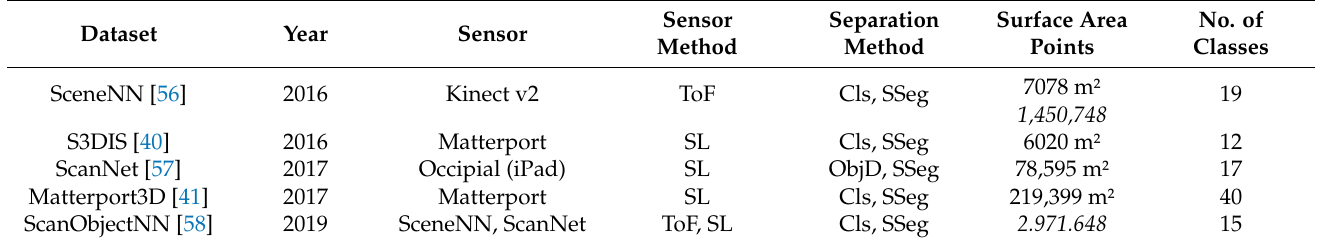
Table 2. Indoor datasets recorded by depth cameras with year of publication, sensor, sensor method, separation method (classification (Cls), object detection (ObjD) and semantic segmentation (SSeg)), surface area and number of